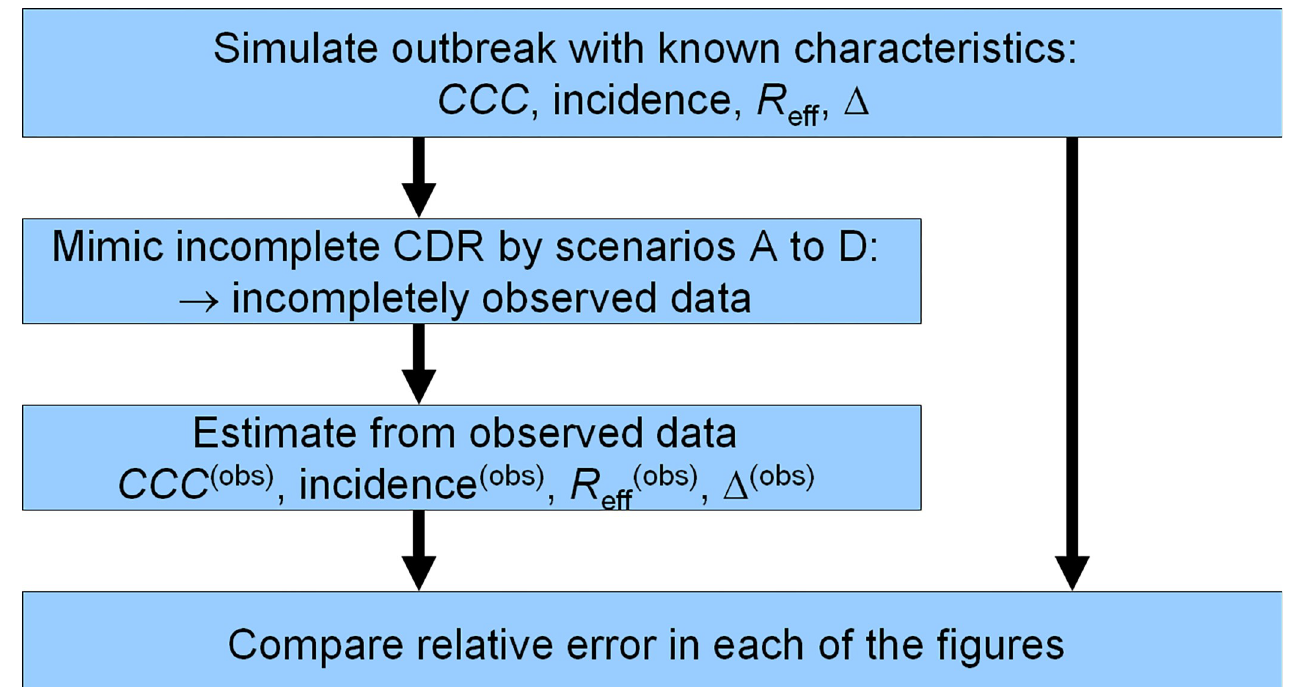
Fig 4. Work flow of the simulation. Work flow for running the simulation and assessing the bias from incomplete case-detection.